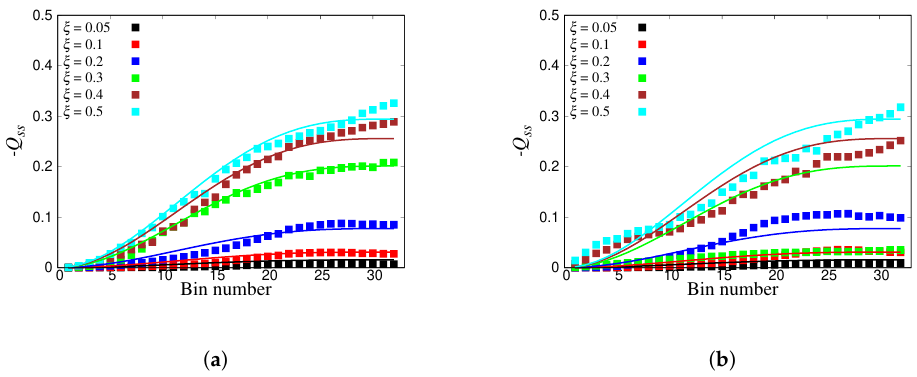
Figure 16. Diagonal components of Q obtained by the ( a ) L (Linear fit) procedure and ( b ) the NL (Nonlinear fit) procedure, for different disorders, ξ , as given in the inset. The symbols denote the direct fits, while the lines provide the normalization condition for